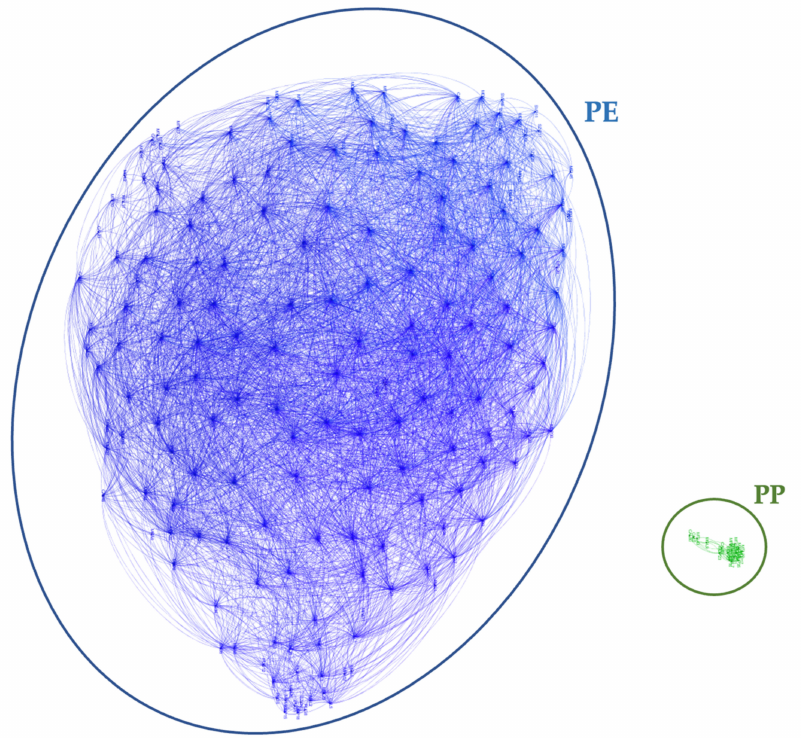
Figure 1. Clustering of the resin pellets according to their composition. The small cluster of green labels at the right corresponds to polypropylene (PP) pellets; the other cluster, far bigger, is of polyethylene (PE) pellets. The Graph Clustering method is able to discriminate, among the analyzed samples, the two types of polymers from their diffuse reflectance spectra. The graph was obtained by setting a correlation threshold of th =